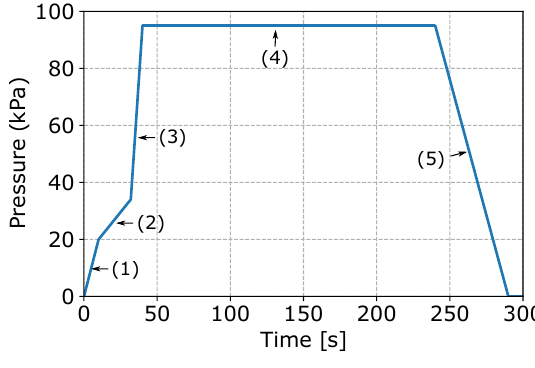
Figure 3. Pressure fill-curve.